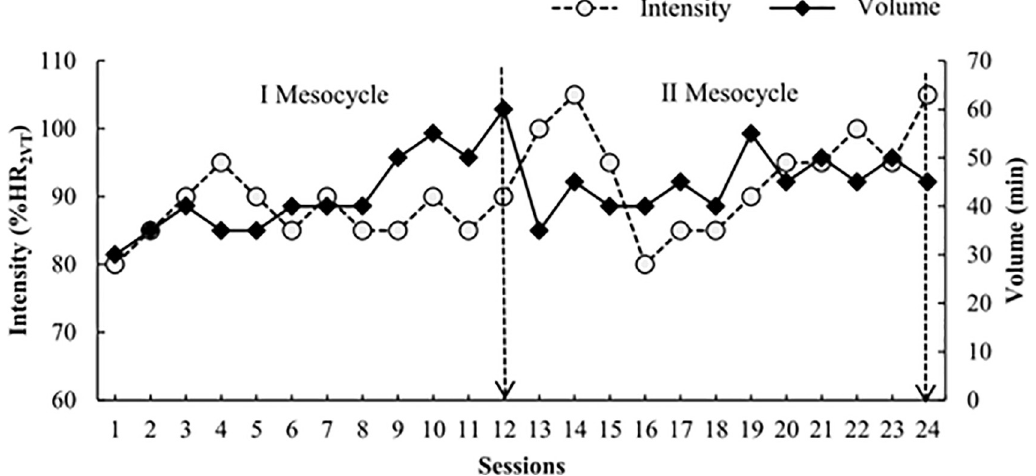
Fig 3. Model of training periodization. The average effort intensity (% heart rate at the second ventilatory threshold, %HR 2VT ) and training volume (in minutes) at every session during the first (I Mesocycle) and second (II Mesocycle) mesocycles.